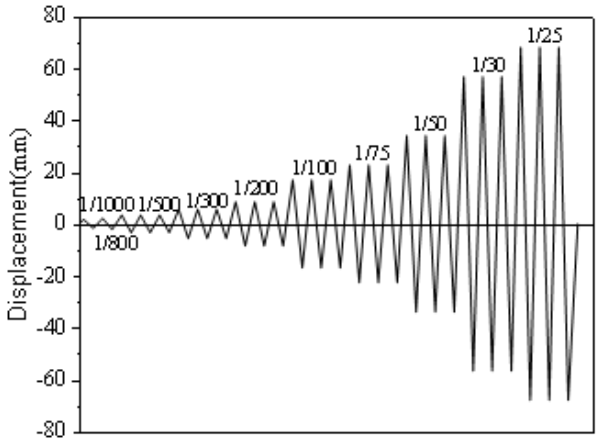
Figure 8. Horizontal loading system.